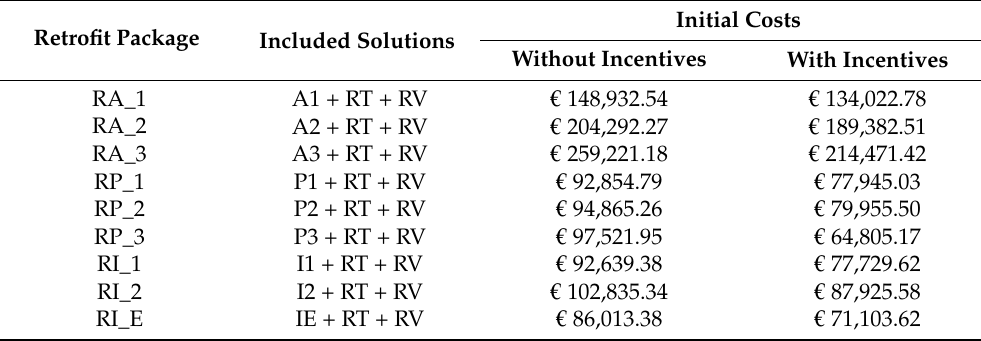
Table 4. Proposed retrofit packages: initial costs (with and without incentives).